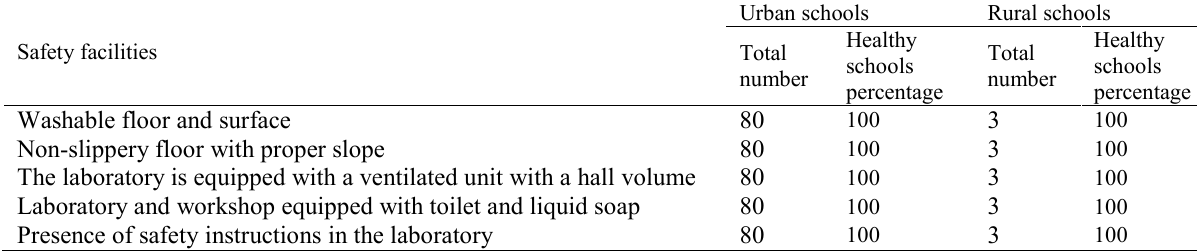
Table 4. Results of the safety situation of the laboratories in Abadan schools Safety